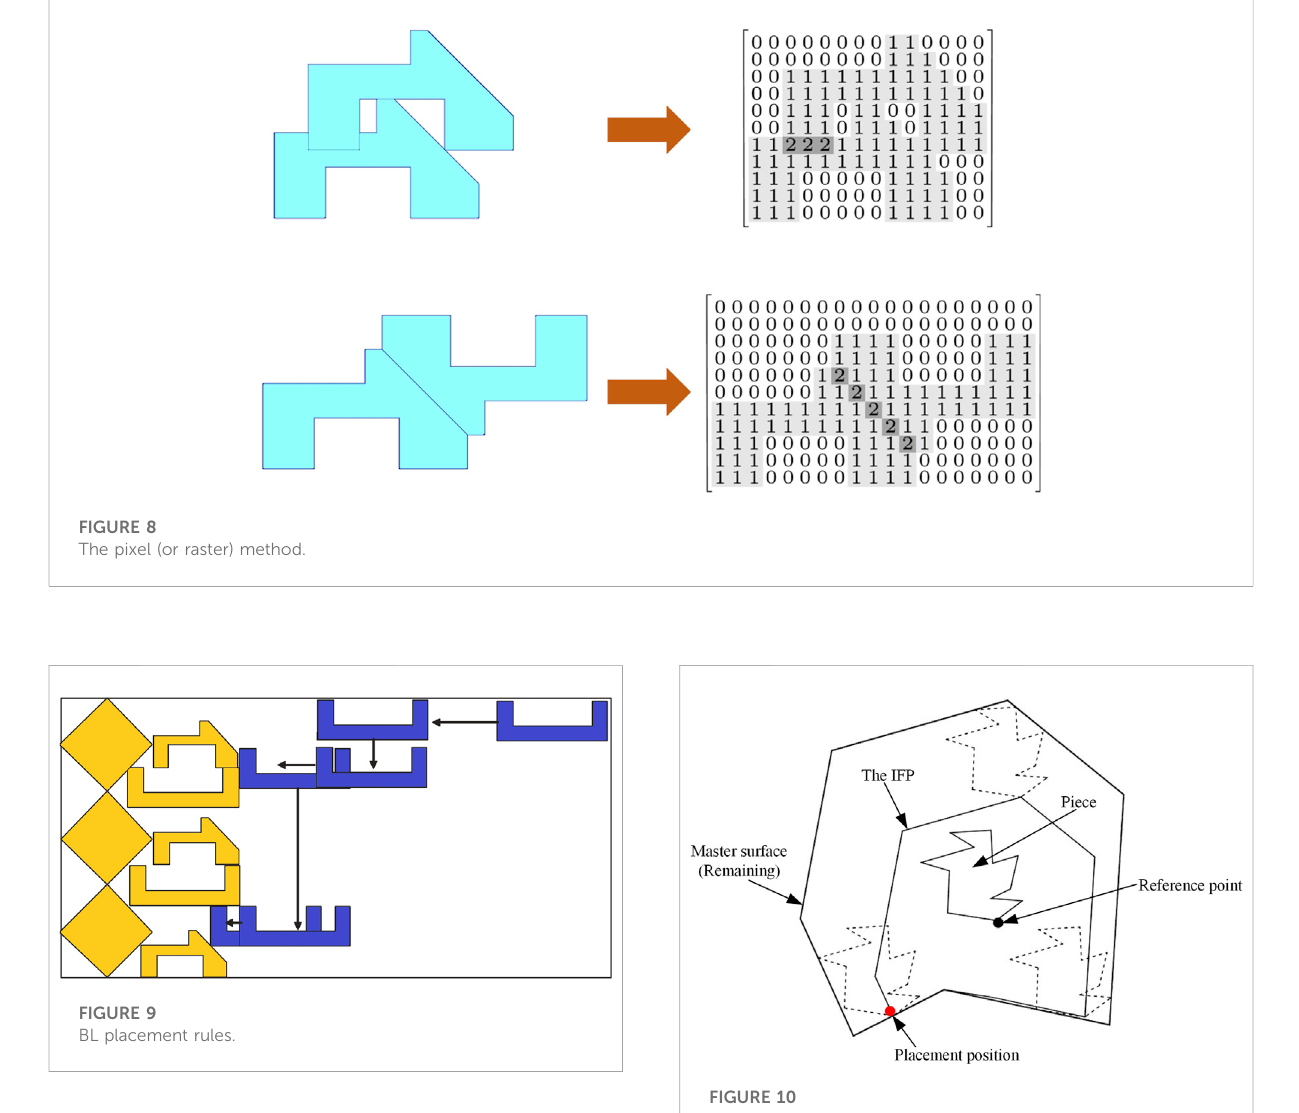
FIGURE 10 Solve the IFP between the remaining space of the master surface and shape.